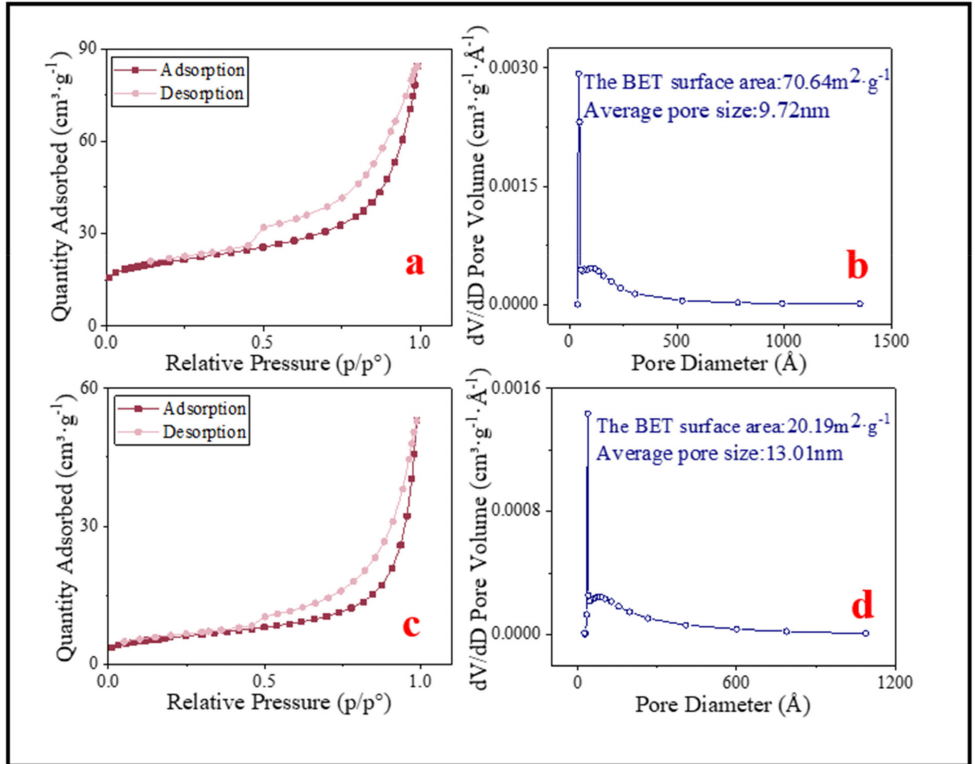
Figure 5. ( a ) N 2 adsorption–desorption isotherm liner plots of BC; ( c ) N 2 adsorption–desorption isotherm liner plots of SMB. ( b ) BJH pore size distribution of BC; ( d ) BJH pore size distribution of